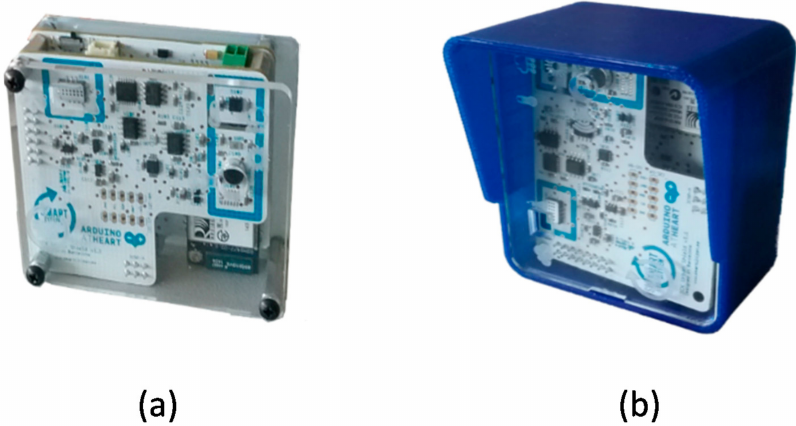
Figure 6. Environmental monitoring device: ( a ) Indoors; ( b )